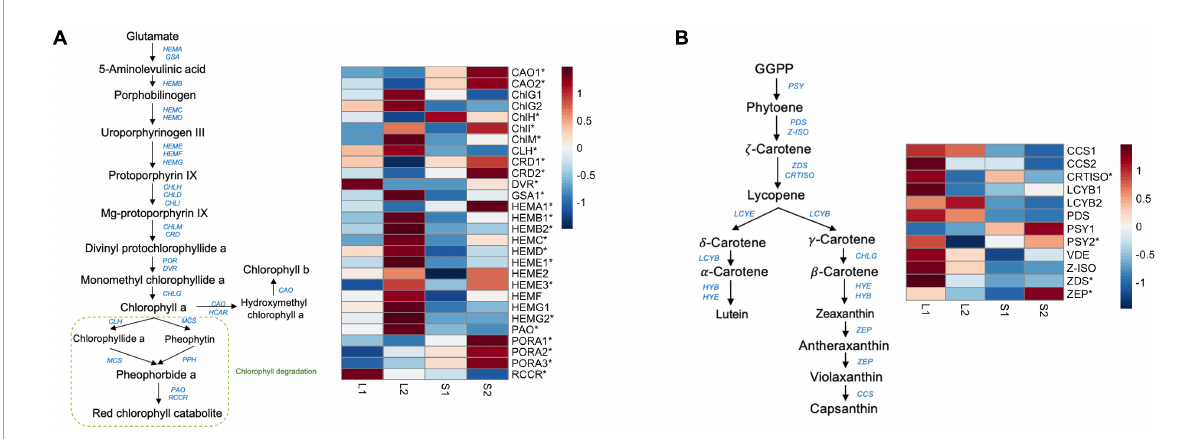
FIGURE2 The expression profile of genes involved in chlorophyll and carotenoid biosynthesis. (A) The candidate genes in the chlorophyll biosynthetic pathway and their expression profiles across four treatment groups; (B) the candidate genes in the carotenoid biosynthetic pathway and their expression profiles across four treatment groups. The star symbols highlight the DEGs in either group